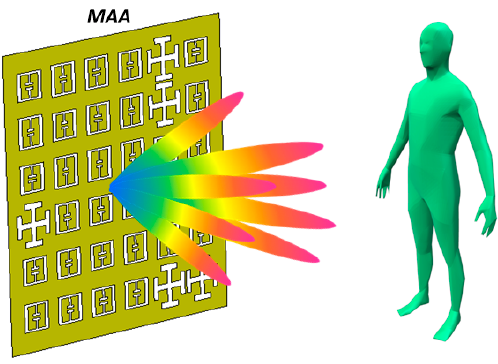
Figure 1. A metamaterial aperture illuminating a human target scene.